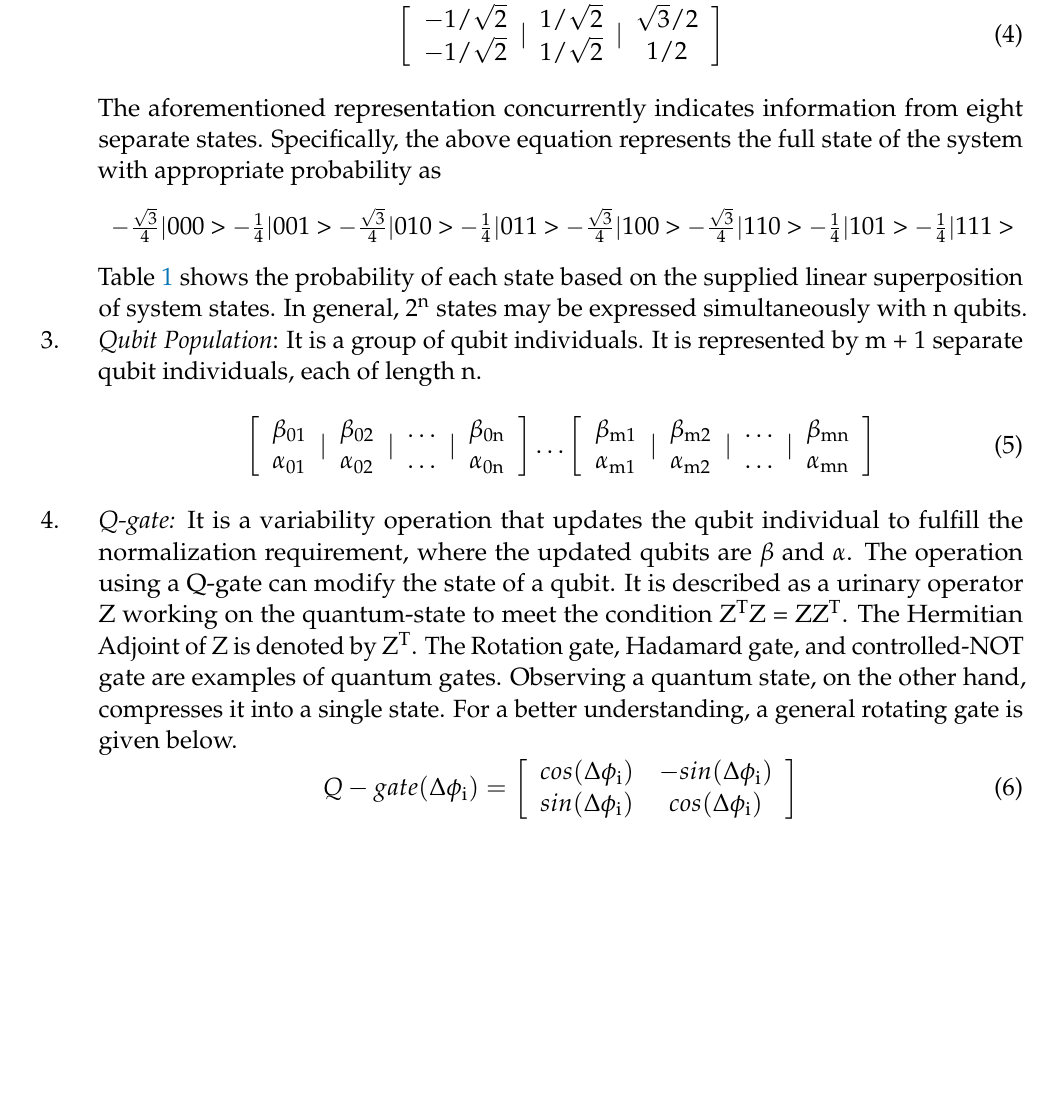
such that n is the qubit number that formulates the qubit individual. The ability to express different states via linear superposition is one of the advantages of qubit individuals. For example, the following is a 3-bit qubit individual.